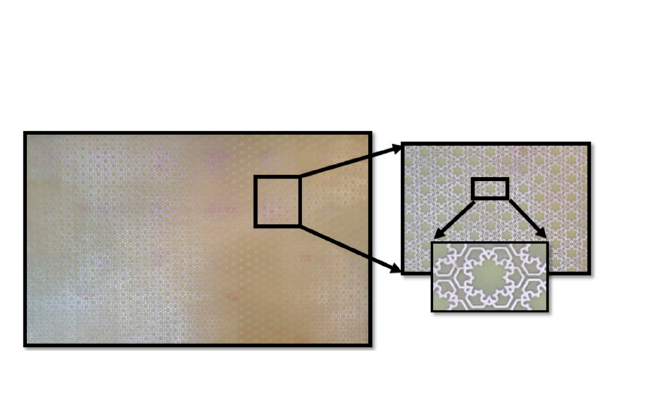
Figure 13. The fabricated prototype of MFSS on both substrates; ( a ) FR4 substrate (210 × 297 mm (cid:2870) ) and ( b ) polycarbonate substrate (300 × 300 mm (cid:2870) ).